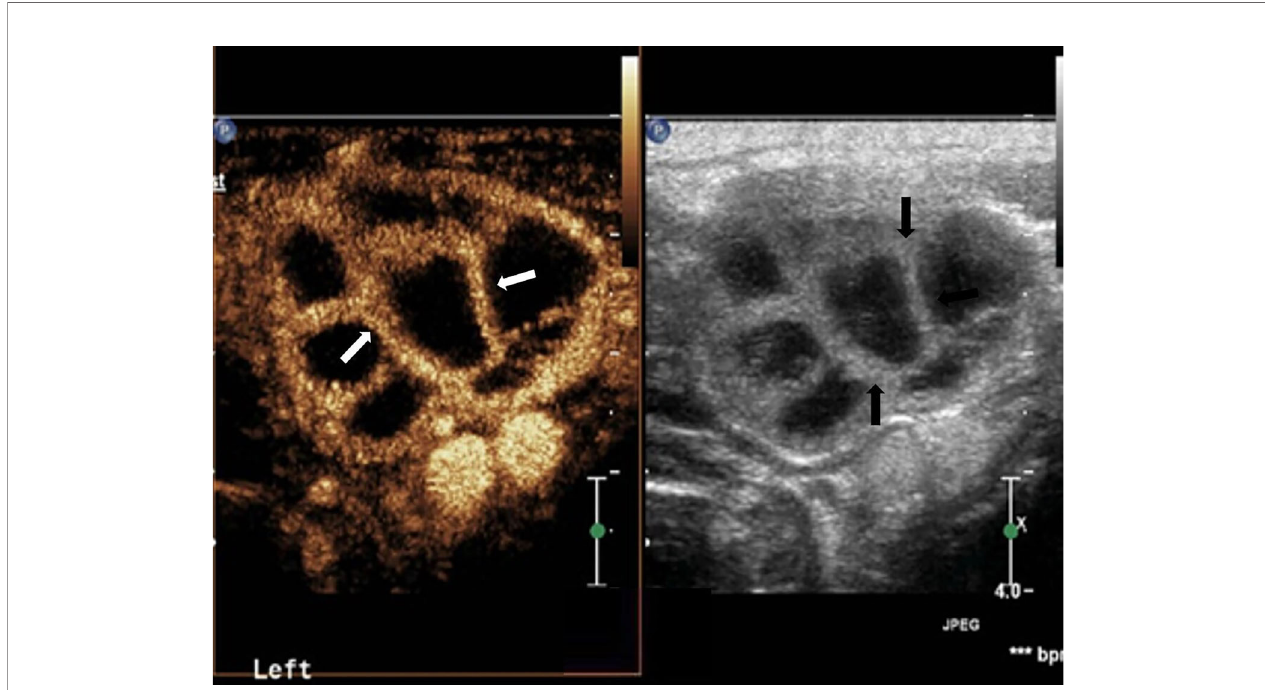
FIGURE 2 | Cervical tuberculous lymphadenitis: lymph node enlargement, absent hilum, honeycomb-like hypoechoic is inside (black arrow). Separated-like enhancement in the arterial phase of lymph nodes (white arrow).